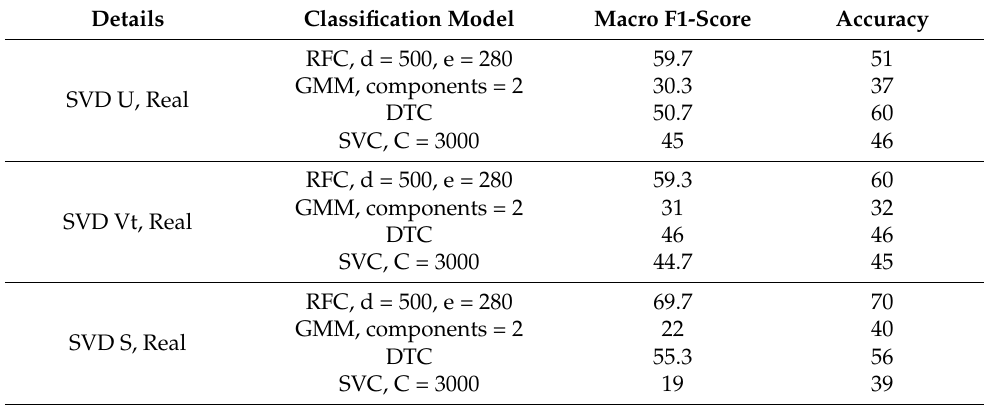
Table 5. Healthy vs COPD vs Pneumonia baseline classification results. All the baseline results have been achieved with the following parameter settings: Random forest (RFC): d = 500, e = 280 (in these, d stands for depth, and e stands for the number of estimators); GMM: components = 2, covariance = full; SVC: gamma = auto, C = 3000.